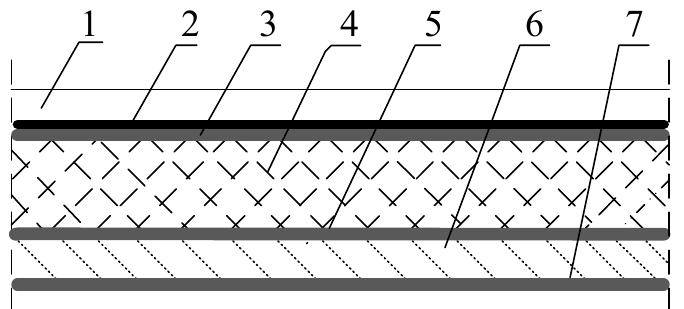
Figure 7. Thermal insulation structure of passive house roof: (1) fine stone concrete; (2) asphalt linoleum; (3) polymer plastering mortar; (4) GEPS insulation; (5) plastering mortar; (6) reinforced concrete; (7) cement plastering mortar.